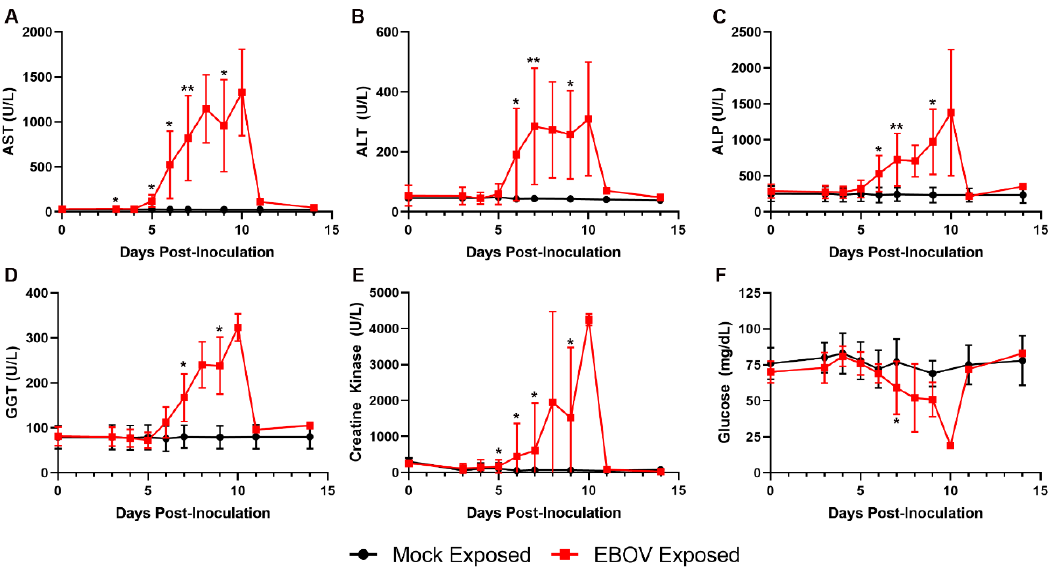
Figure 9. Exposure to IM EBOV in rhesus macaques produces clinical pathology alterations consistent with hepatocellular damage and necrosis and other disease conditions. Group means ± SD of: aspartate aminotransferase (AST) ( A ); alanine aminotransferase (ALT) ( B ); alkaline phosphatase (ALP) ( C ); gamma glutamyl transferase (GGT) ( D ); creatine kinase ( E ); and glucose ( F ). X-axes are truncated to highlight responses occurring from the first sampling point through the acute disease phase. * p < 0.05; ** p < 0.001. p -values are indicated for comparison of change-from-baseline values in mock- vs. EBOV-exposed animals on the indicated study day.